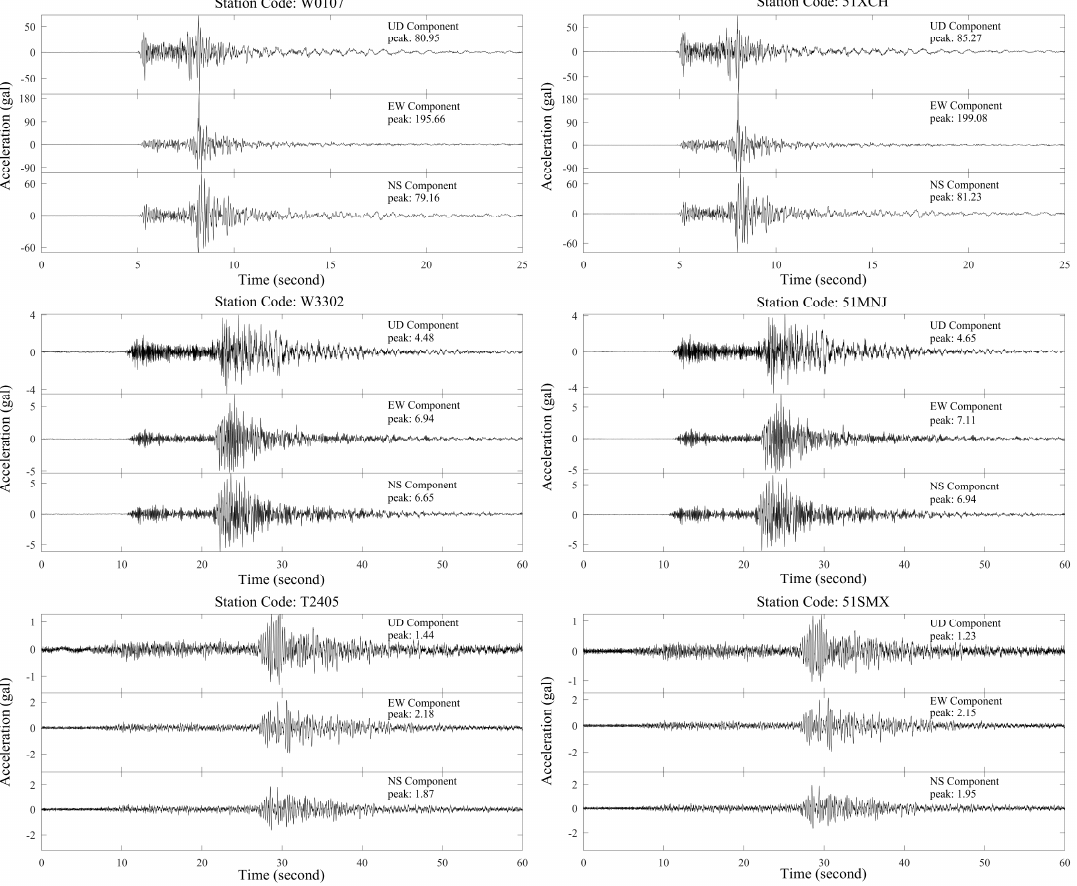
Figure 5. Examples of three-component accelerations from 31 October 2018, M 5.1 Xichang earthquake at the following co-located station pairs: W0107&51XCH, W3302&51MNJ, and T2405&51SMX. Stations 51XCH, 51MNJ, and 51SMX are traditional strong-motion stations with trigger-mode data transmission.